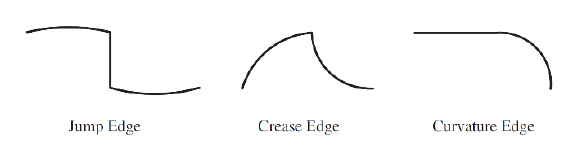
Figure 5. Three types of ground breaklines defined in Brugelmann, (2000).